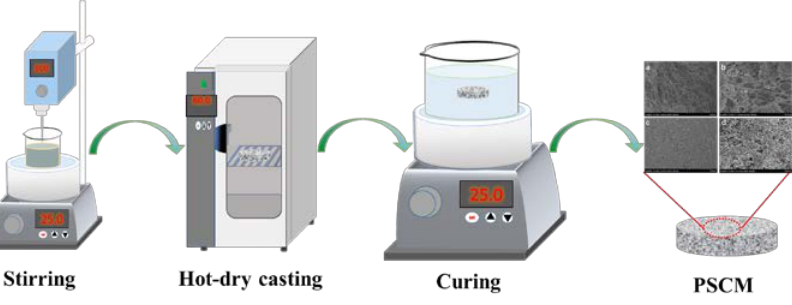
Figure 1. Schematic diagram of the hot–dry casting technique for fabricating the porous silicate cement membrane (PSCM).